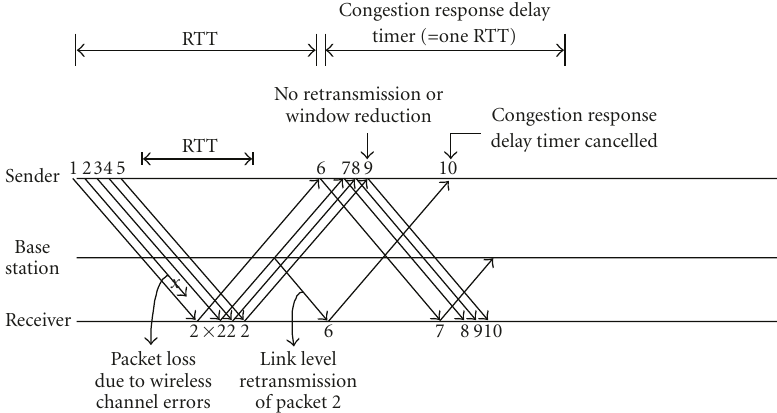
Figure 5: Behavior of the proposed scheme II: packet-reordering due to retransmission at wireless link layer.